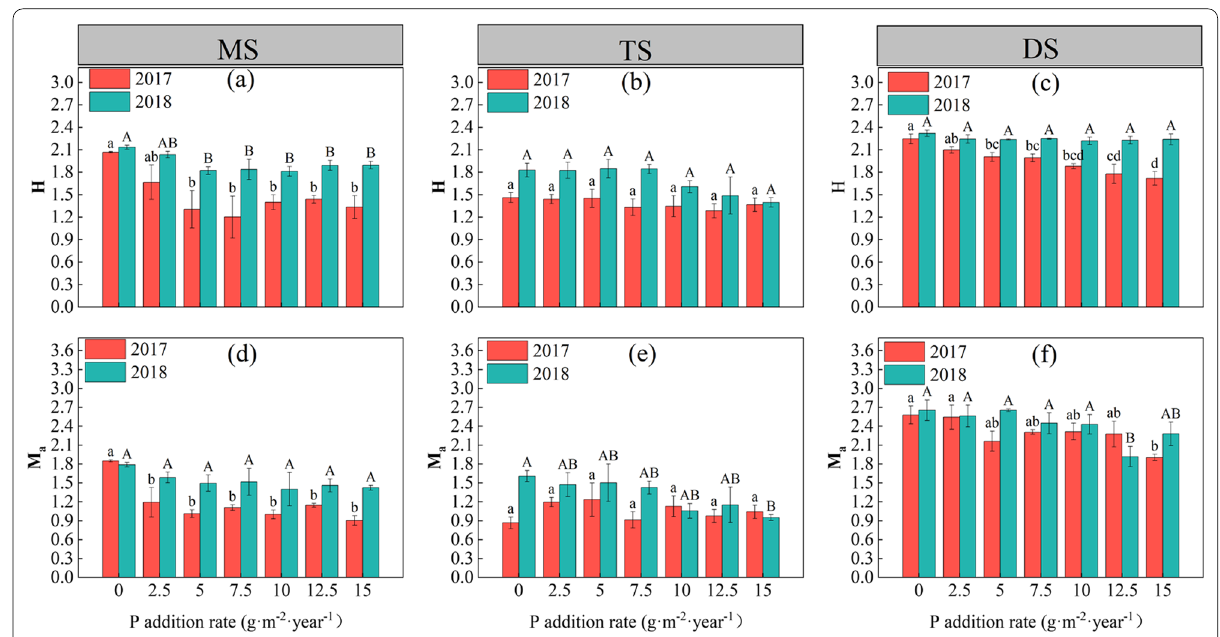
Fig. 5 Effects of experimental P addition on the Shannon-Wiener (( a ) MS, ( b ) TS, ( c ) DS) and Margalef richness (( d ) MS, ( e ) TS, ( f ) DS) of three temperate steppes from 2017 to 2018